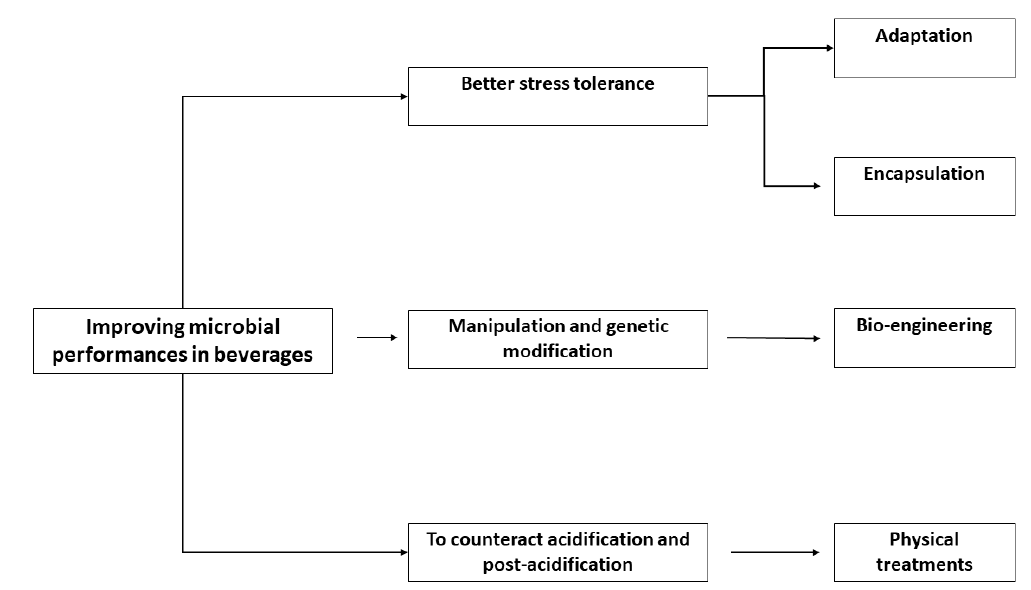
Figure 1. Strategies to improve the performances of probiotics in beverages.